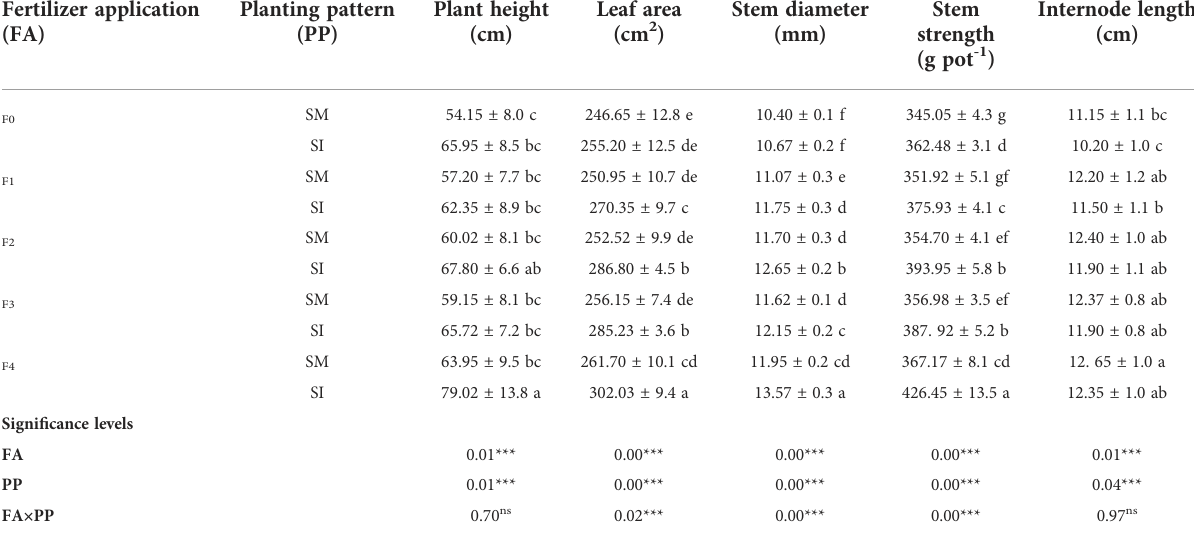
TABLE 1 Growth indices of soybean crop as in fl uenced by different fertilizer application and planting patterns. Fertilizer application